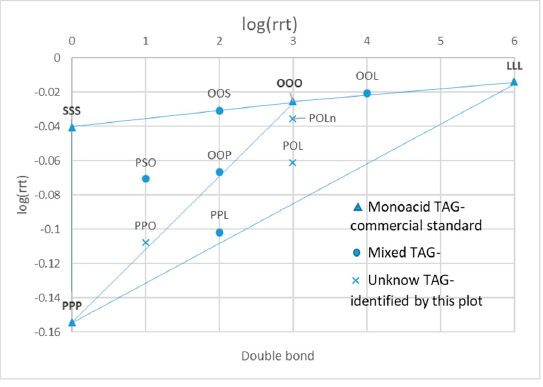
Figure 4. Plot for identification of unknown TGs in the tested refined rapeseed oil (RRO) and olive oil (OO).